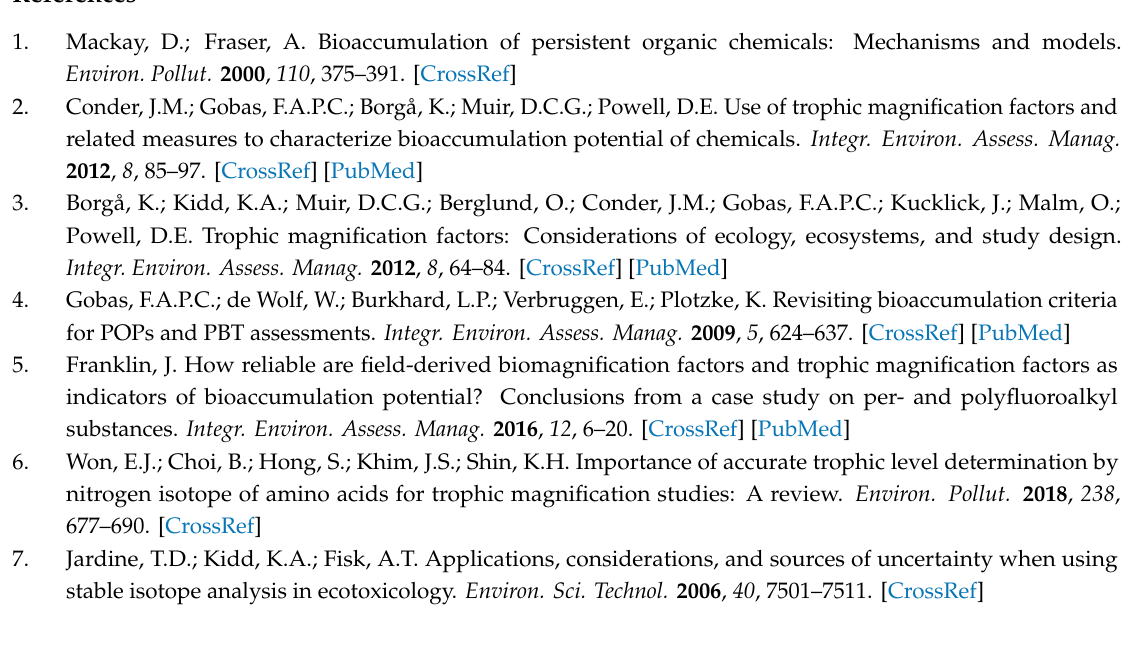
Figure S1. Comparison between Fishbase TLs and measured TLs. Figure S2. Derived TMFs of Hg for lake food web, including zooplankton, (left) and for fish-only food web (right). Confidence band (95%) is represented in grey. Figure S3. Derived TMFs of PFOS for lake food web, including zooplankton, (left) and for fish-only food web (right). Confidence band (95%) is represented in grey. Table S1. Lake Mergozzo morphometric characteristics. Table S2. Hg concentrations ( µ g kg − 1 ww) in samples. Table S3. DDT concentrations ( µ g kg − 1 lw) in samples. Table S4. PCB concentrations ( µ g kg − 1 lw) in samples. Table S5. PFAS concentrations ( µ g kg − 1 ww) in samples. Table S6. Data comparison among results of this study and fish concentrations in European lakes. Concentrations are expressed in µ g kg − 1 lw for DDTs and PCBs and in µ g kg − 1 ww for PFAS and for Hg. For each species, mean, minimum and maximum (in brackets) values are